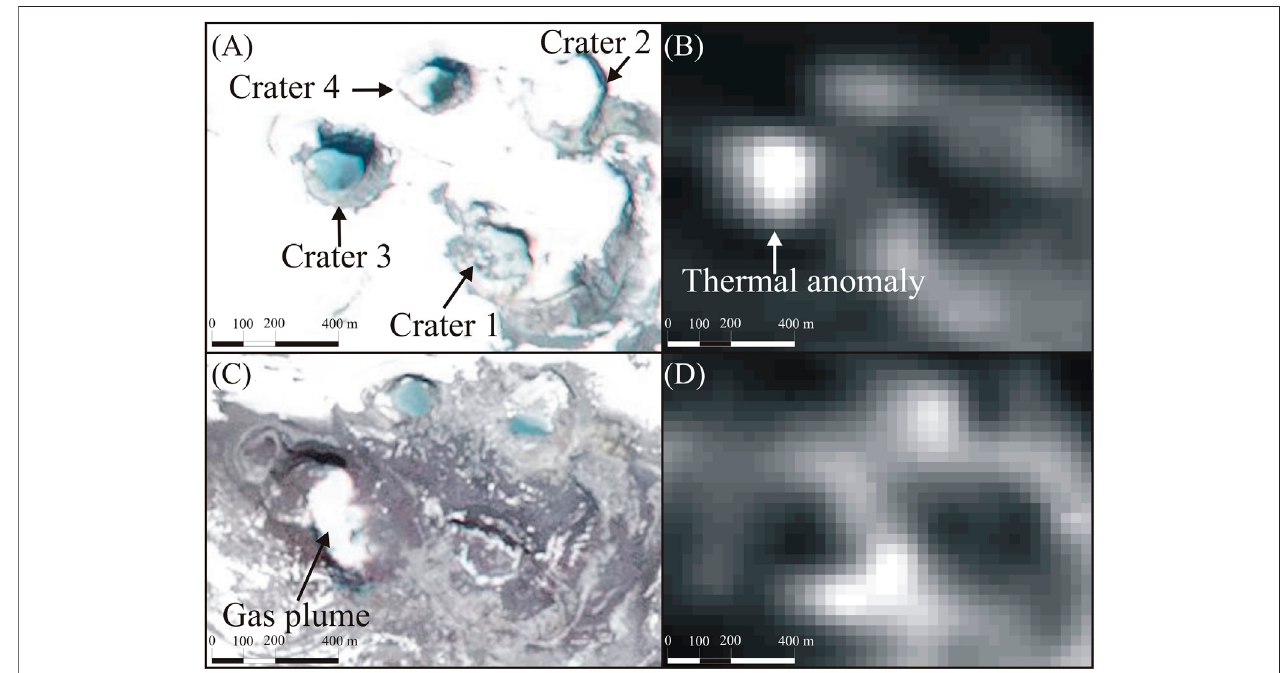
FIGURE 8 | (A) RapidEye image (natural color) showing the crater lakes on October 3, 2009. (B) Landsat TM Thermal Infrared Band (TIR) showing the thermal anomaly on Crater Lake 3 (October 3, 2009). (C) RapidEye image (natural color) showing the crater lakes on November 15, 2011. A gas plume emitted from Crater 3 is also shown. (D) Landsat TM Thermal Infrared Band (TIR) showing no thermal anomalies (November 17,